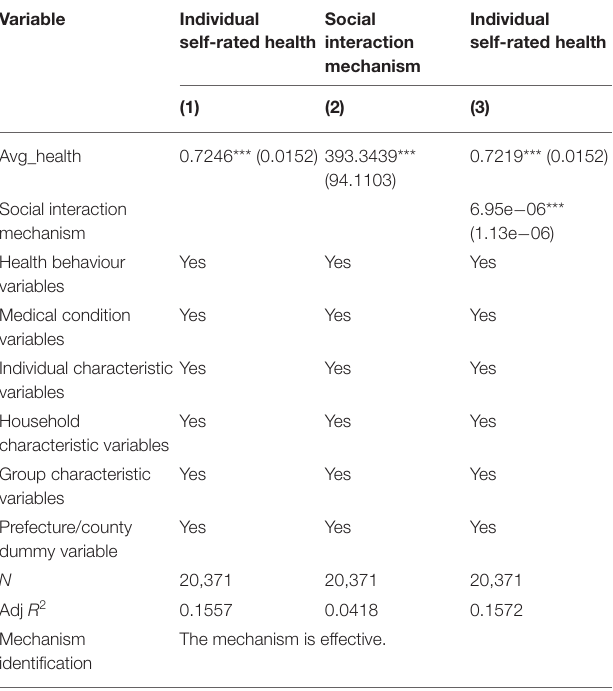
TABLE 10 | Test results on the social interaction mechanism of health contagion.